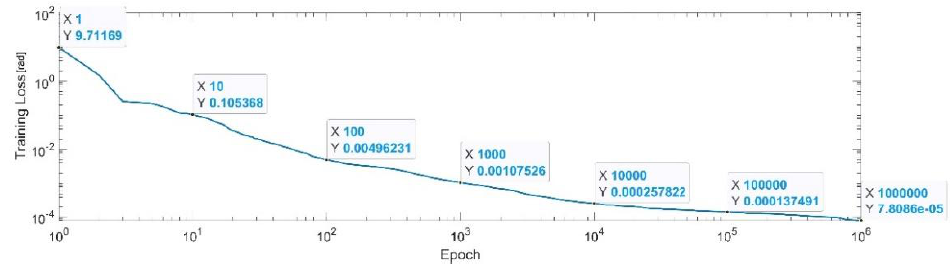
Figure 15. Convergence of the neural network for the first generalized coordinate 𝑞 3 (log scale).